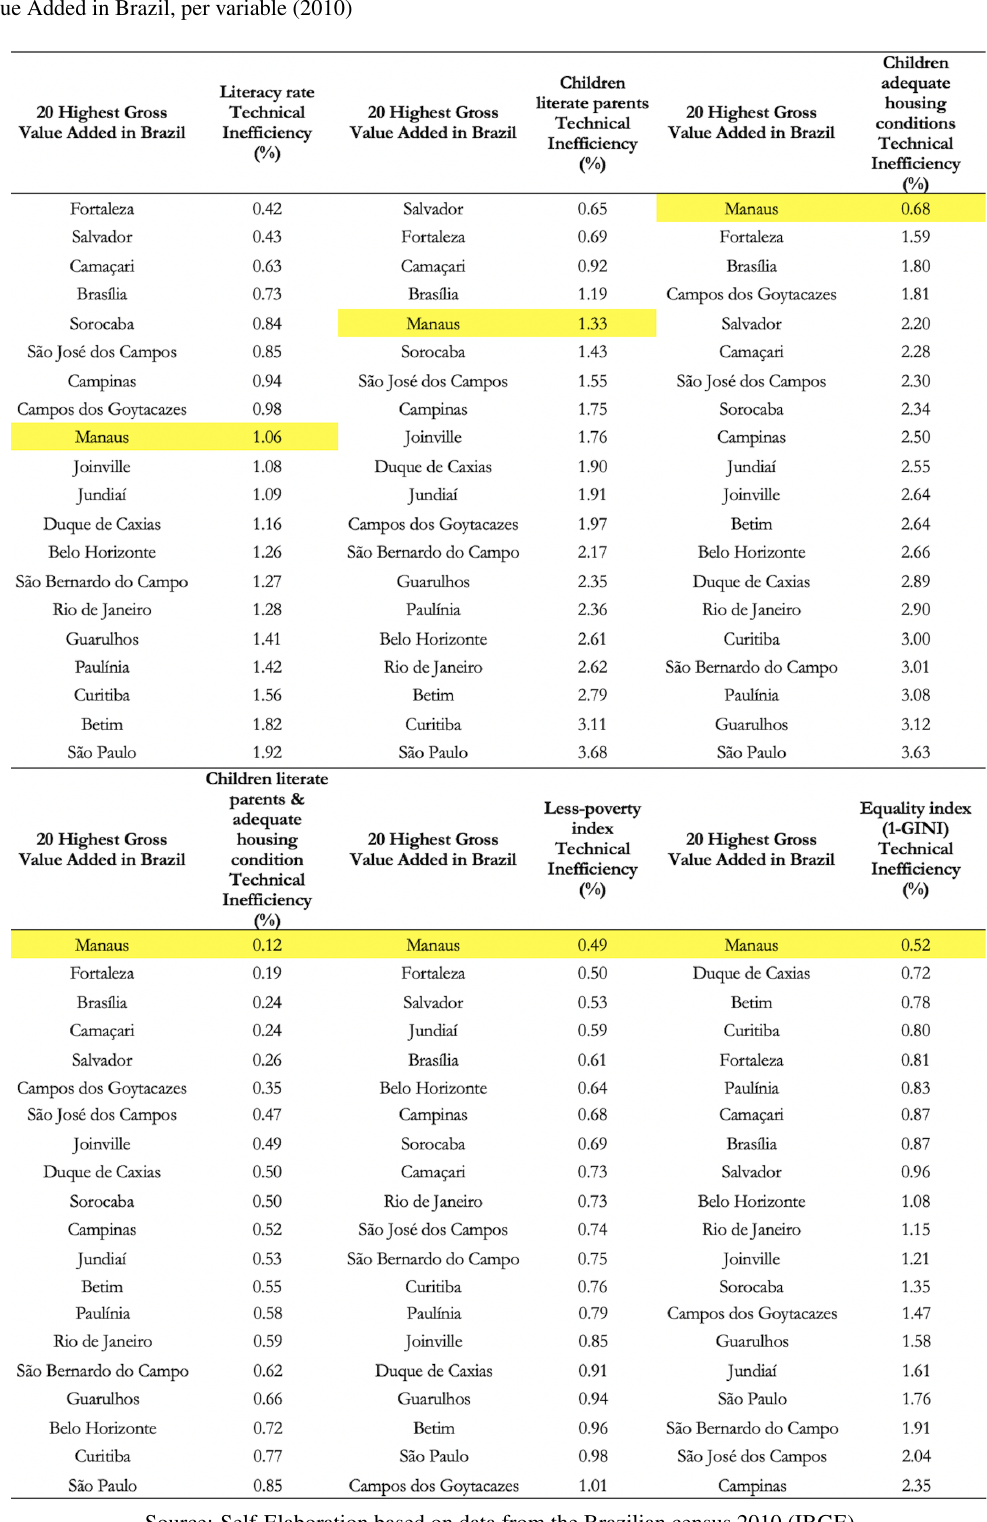
Table 20: Ranking of Social Indicators Inefficiency (Model B) - per 20 municipalities with the highest industry Gross Value Added in Brazil, per variable